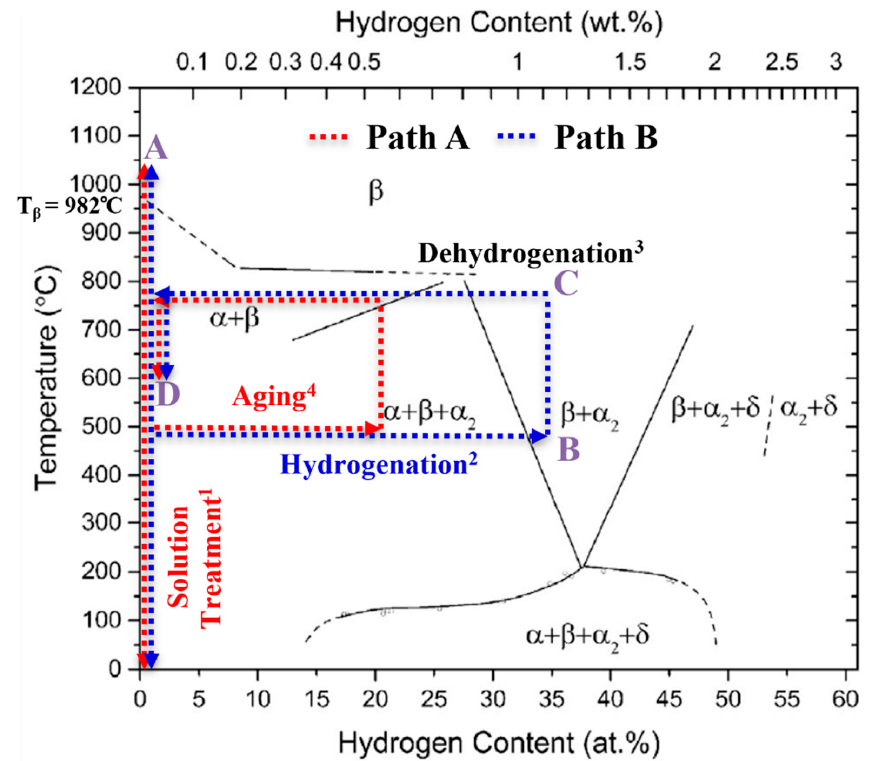
two different concepts of THT (path A, red dotted lines and Bm blue dotted lines), which differ in terms of maximal hydrogen concentration established in the near-surface area.